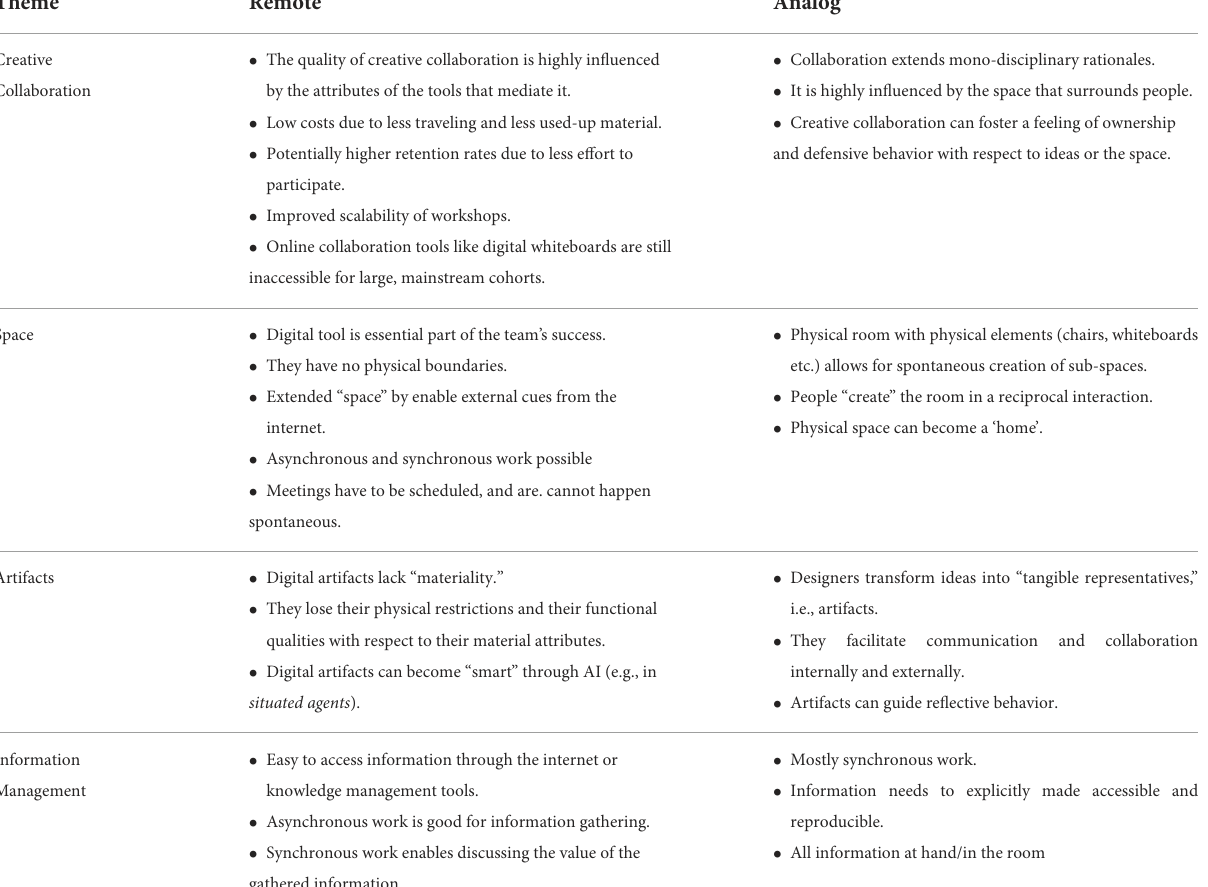
TABLE 1 Key results of literature review for remote and analog Design Thinking. Theme Remote